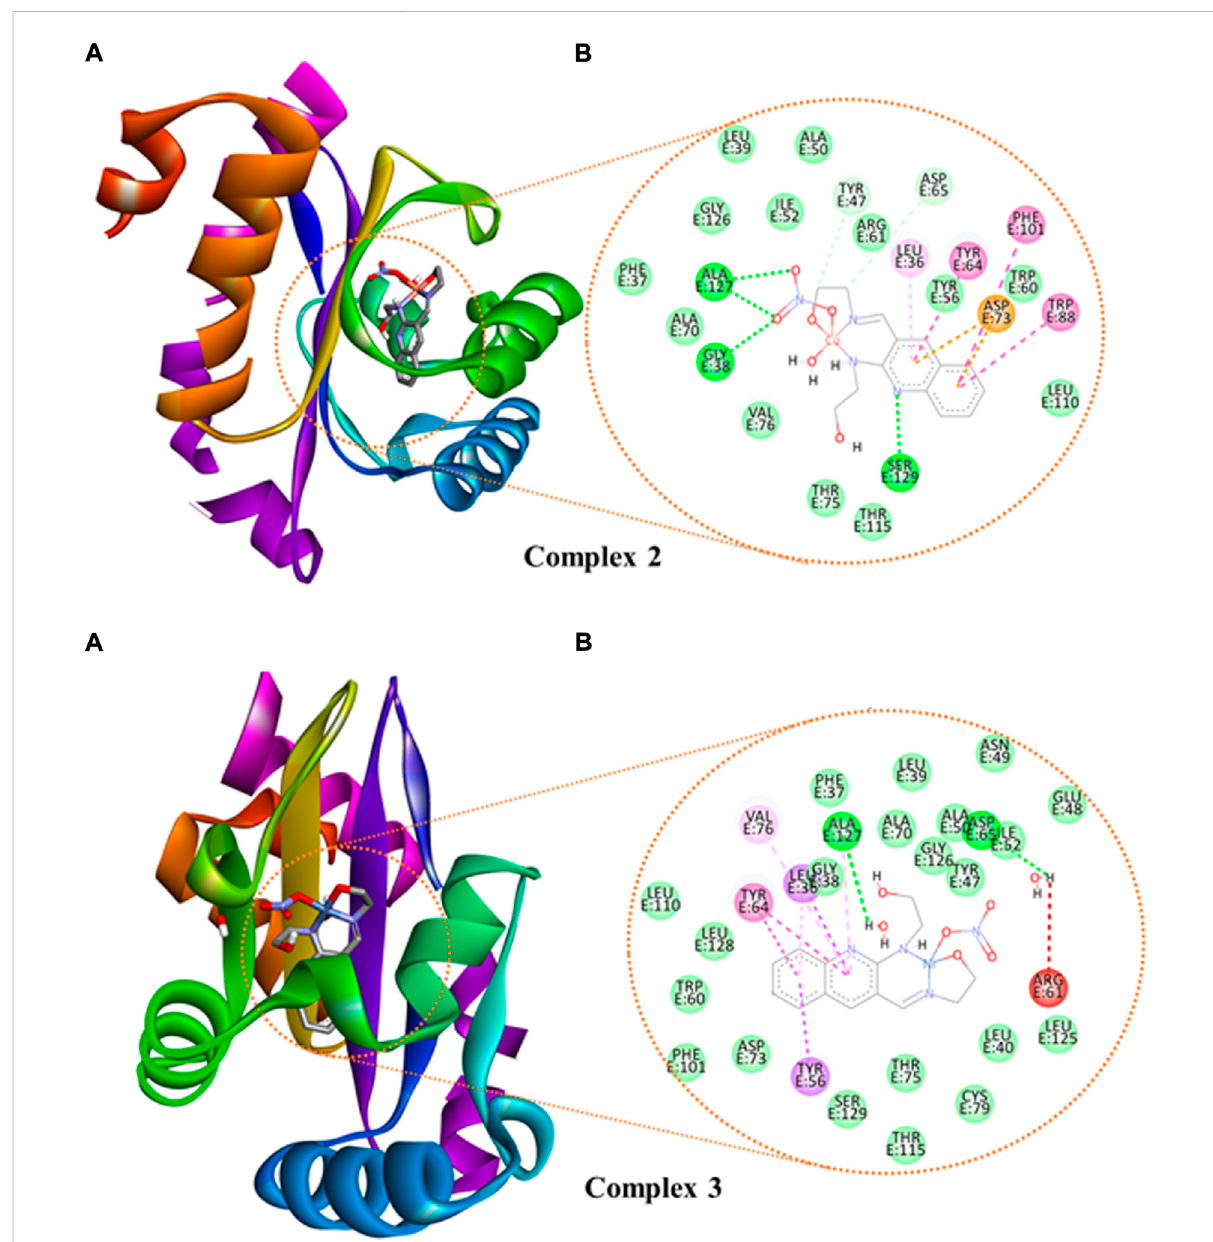
FIGURE 8 The binding interactions of ( (A) : 3D and (B) : 2D presentations) of complexes 2 and 3 against P. aeruginosa LasR.DNA (PDB: